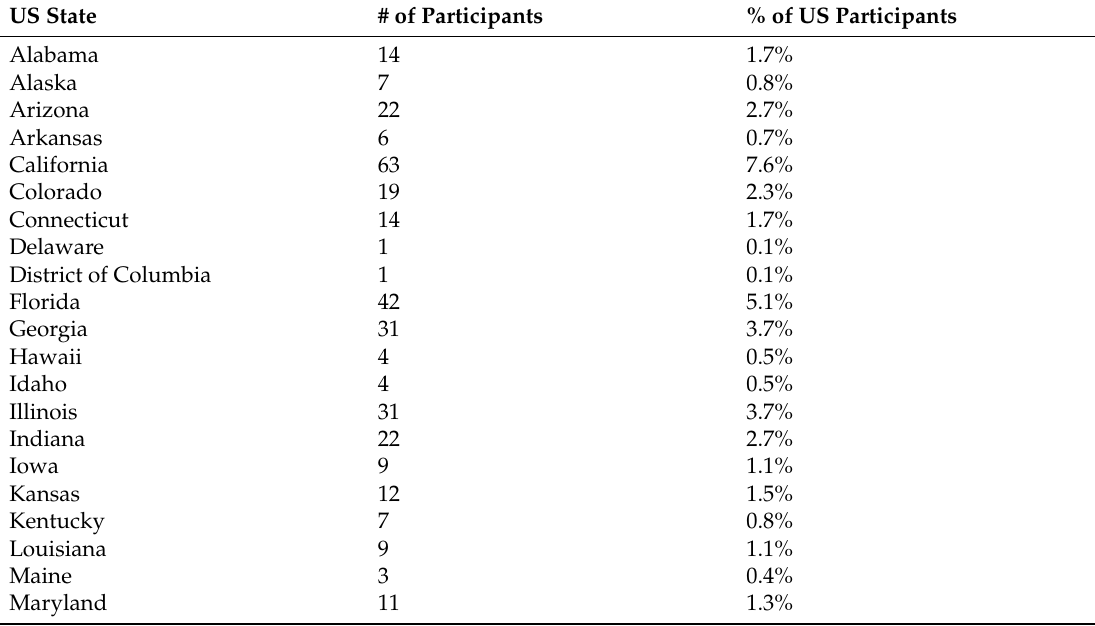
Table 4. Distribution of US participants within the Global PWS Registry by state. Participants within the Registry represent all 50 states within the United States. Of participants that live in the United States, California, Texas, New York, and Florida have the highest reported number of